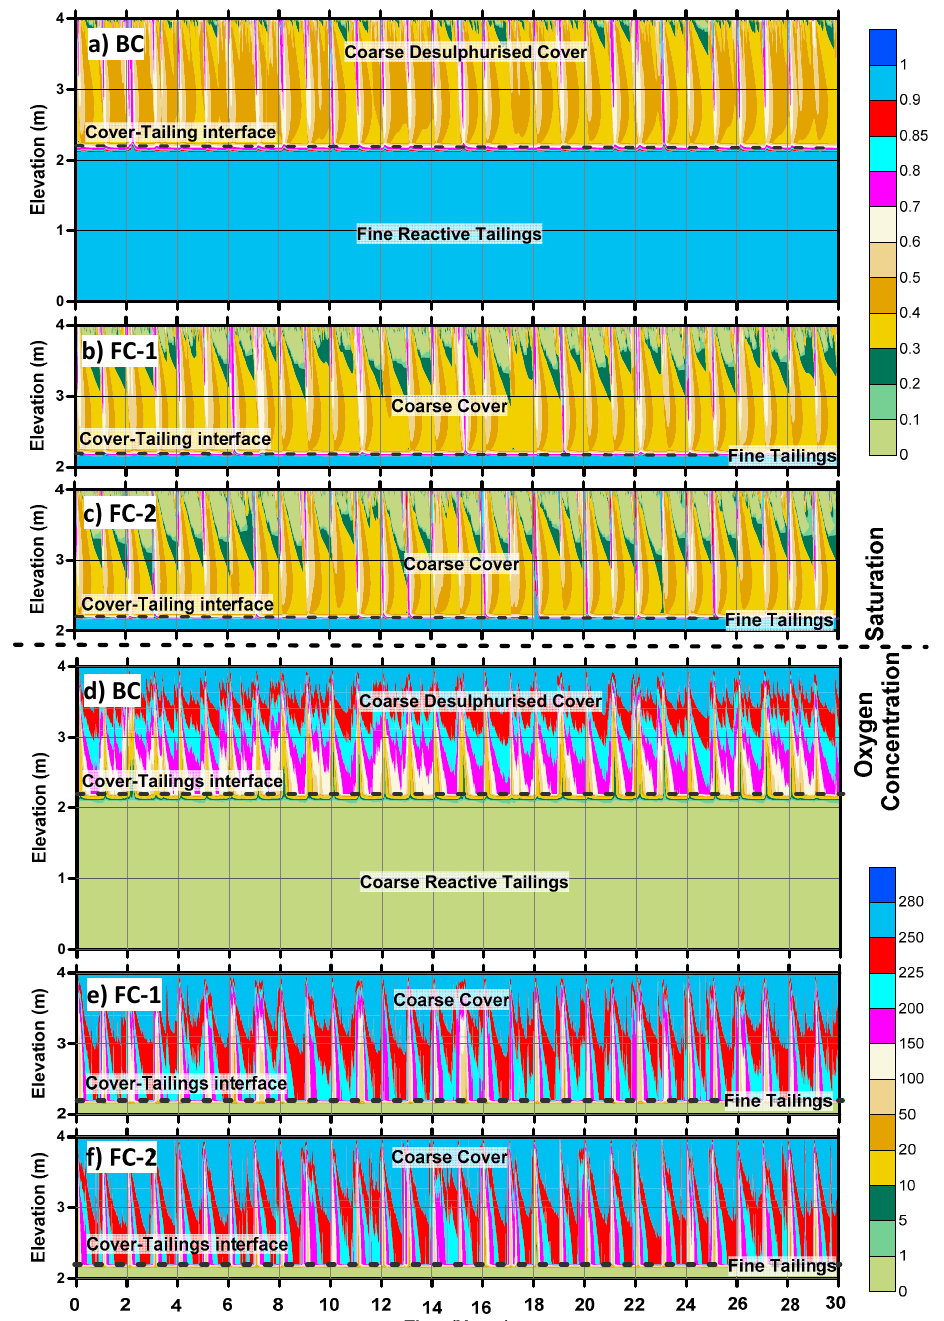
Figure 14. Comparison of 30-year time histories of saturation and oxygen concentration for the CF profile. Saturation for climates ( a ) BC, ( b ) FC-1, and ( c ) FC-2; and oxygen concentration for climates ( d ) BC, ( e ) FC-1 and ( f ) FC-2.